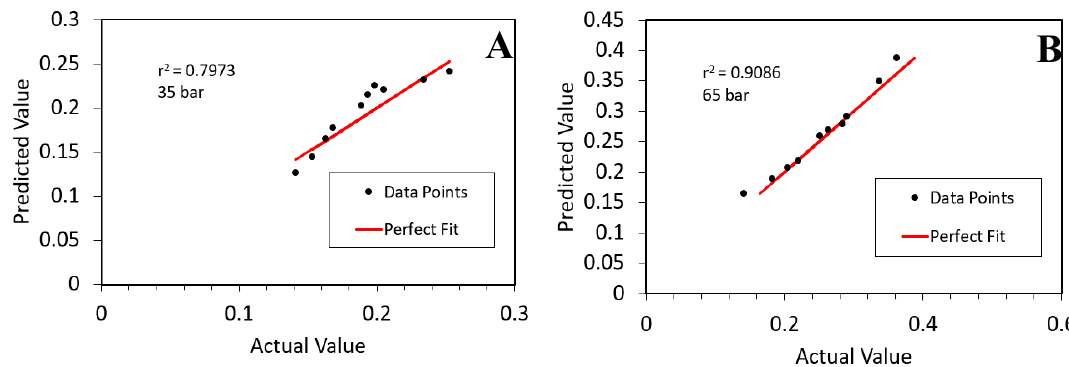
Figure 6. Predictive power of proposed models for CH 4 uptake. ( A ) Equation (4) for CH 4 gravimetric uptake at 35 bar and 298 K and ( B ) Equation (5) for CH 4 gravimetric uptake at 65 bar and 298 K. A perfect fit is indicated by the red line and the test set of MOFs are denoted by black circles. BET surface area is the descriptor. Black circles represent experimental data points.